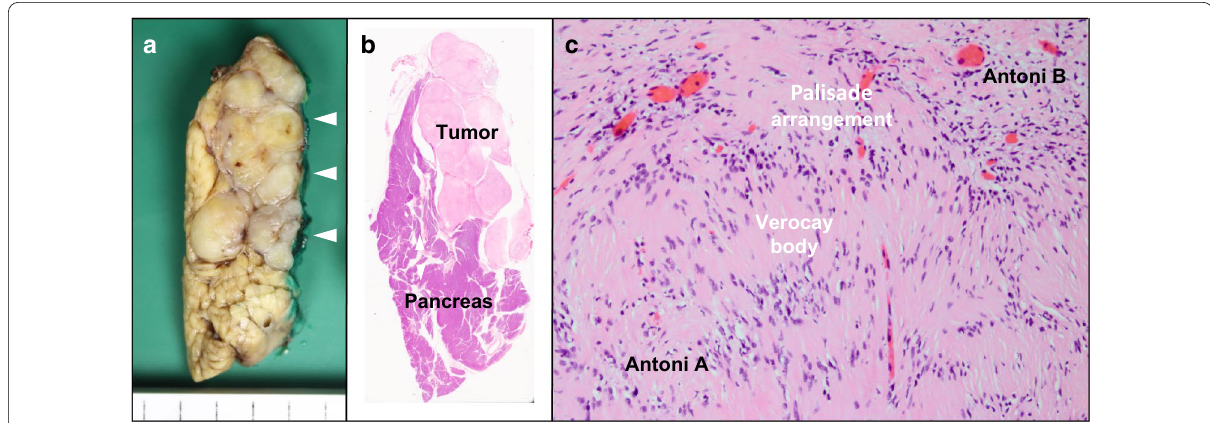
Fig. 5 Macroscopic and microscopic findings of the resected specimen. a Cut surface of the resected specimen showed that the tumor was white-yellowish, well-demarcated, and multinodular. There was no pancreatic parenchyma on the dorsal surface of the tumor (triangles). b Loupe image. c The tumor cells were spindle-shaped and had a palisading arrangement, forming structures called Verocay bodies in hypercellular Antoni A areas. Hypocellular areas, called Antoni B areas, were also visible. Mitosis was rarely seen. Hematoxylin–eosin staining, original magnification 200